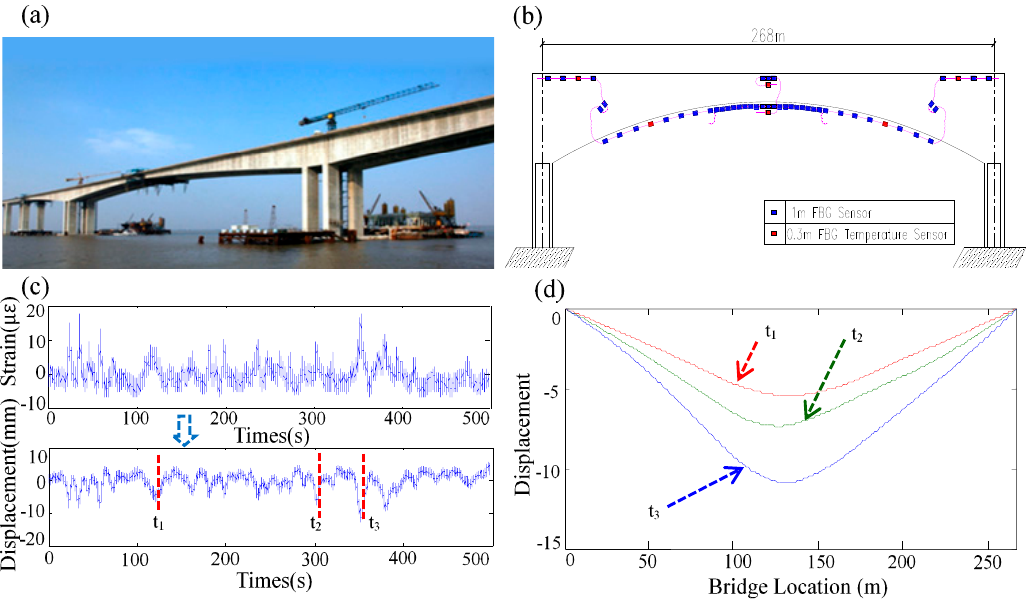
Figure 10. Area-wise distributed monitoring of the Sutong Auxiliary Bridge: ( a ) Bridge Photo; ( b ) Sensor layout; ( c ) measured long gauge strain and identified deflection; ( d ) Deflection distribution [70].